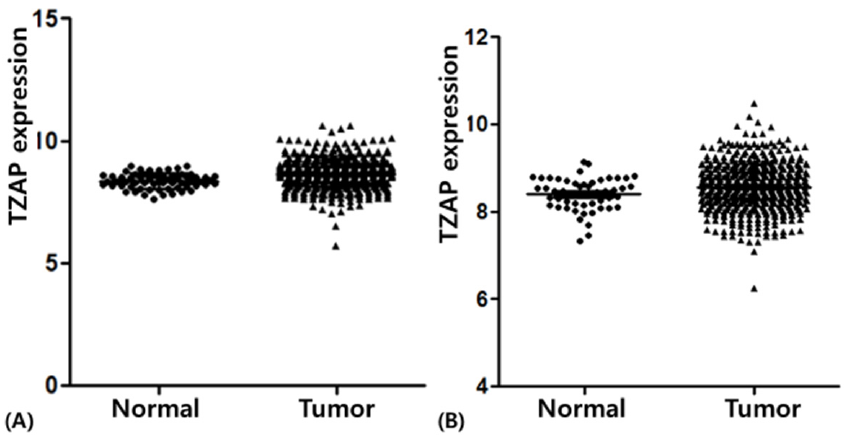
Figure 1. TZAP expression in lung cancer and normal tissues: ( A ) adenocarcinoma; ( B ) squamous cell carcinoma.